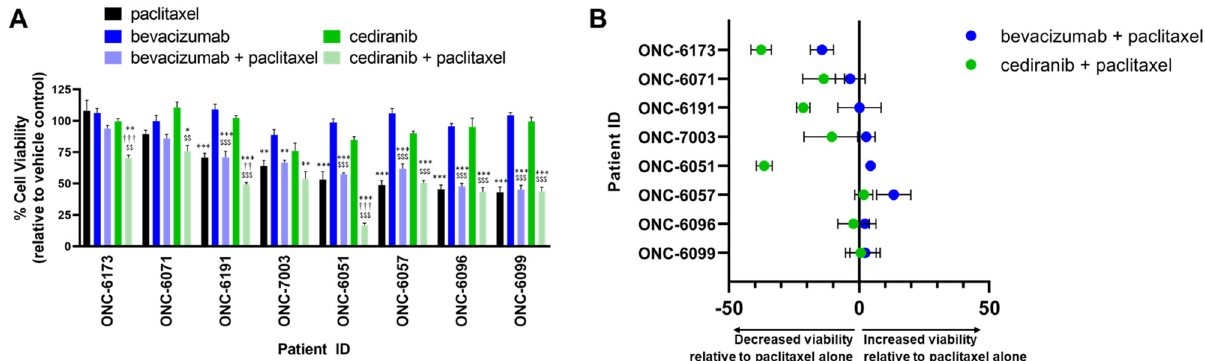
Figure 2. Effect of cediranib and bevacizumab on sensitivity to paclitaxel in patient-derived organoid cultures of primary endometrial tumors. Organoid cultures were treated with 10 nM paclitaxel, 1 µM bevacizumab, 1 µM cediranib, or the combination of paclitaxel with bevacizumab or cediranib for 72 hrs, followed by assessment of cell viability. ( A ) Data were calculated as the percent (%) cell viability as compared to vehicle control and plotted left-to-right by increasing sensitivity to single-agent paclitaxel. ( B ) The change in viability with the combination of paclitaxel with either bevacizumab or cediranib was calculated relative to paclitaxel alone. * p < 0.05, ** p < 0.01, *** p < 0.001 versus control; †† p < 0.01, ††† p < 0.001 versus paclitaxel alone; $$ p < 0.01, $$$ p < 0.001 versus anti-angiogenic agent alone (bevacizumab for bevacizumab + paclitaxel or cediranib for cediranib + paclitaxel treated samples) by ordinary one-way ANOVA with Tukey’s multiple comparisons test.